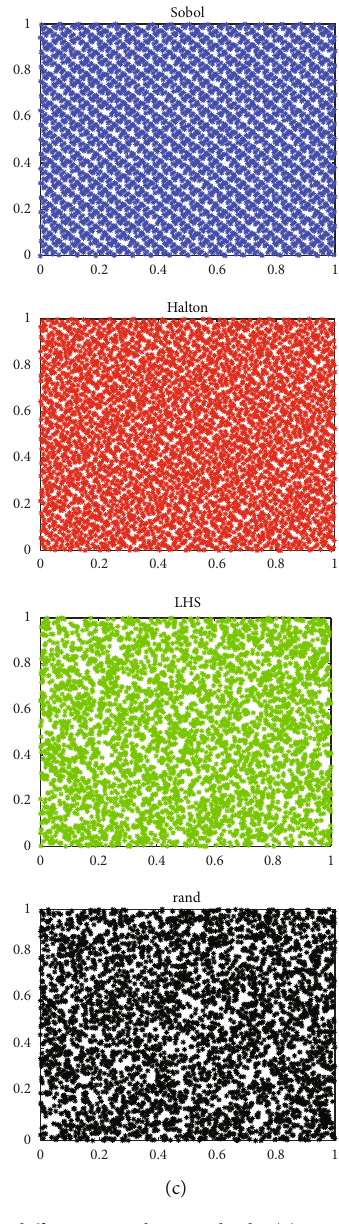
Figure 3: Distribution of data points generated by di ff erent sampling methods: (a) 100 sampling points, (b) 1000 sampling points, and (c) 4000 sampling